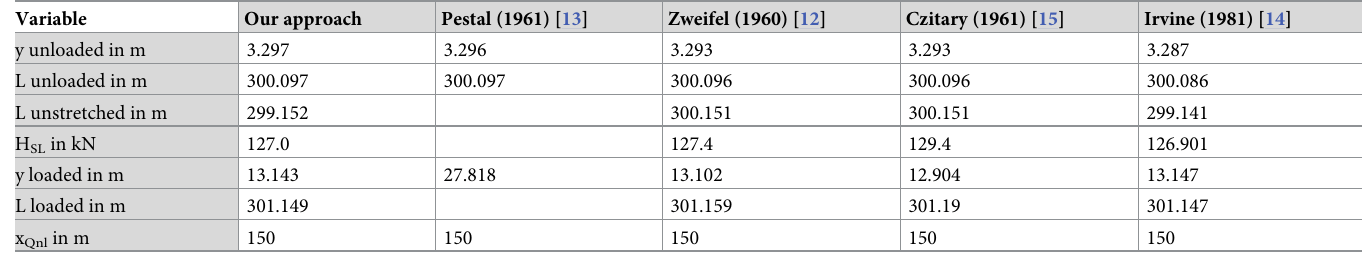
Table 2. Display of the solutions of a flat example.